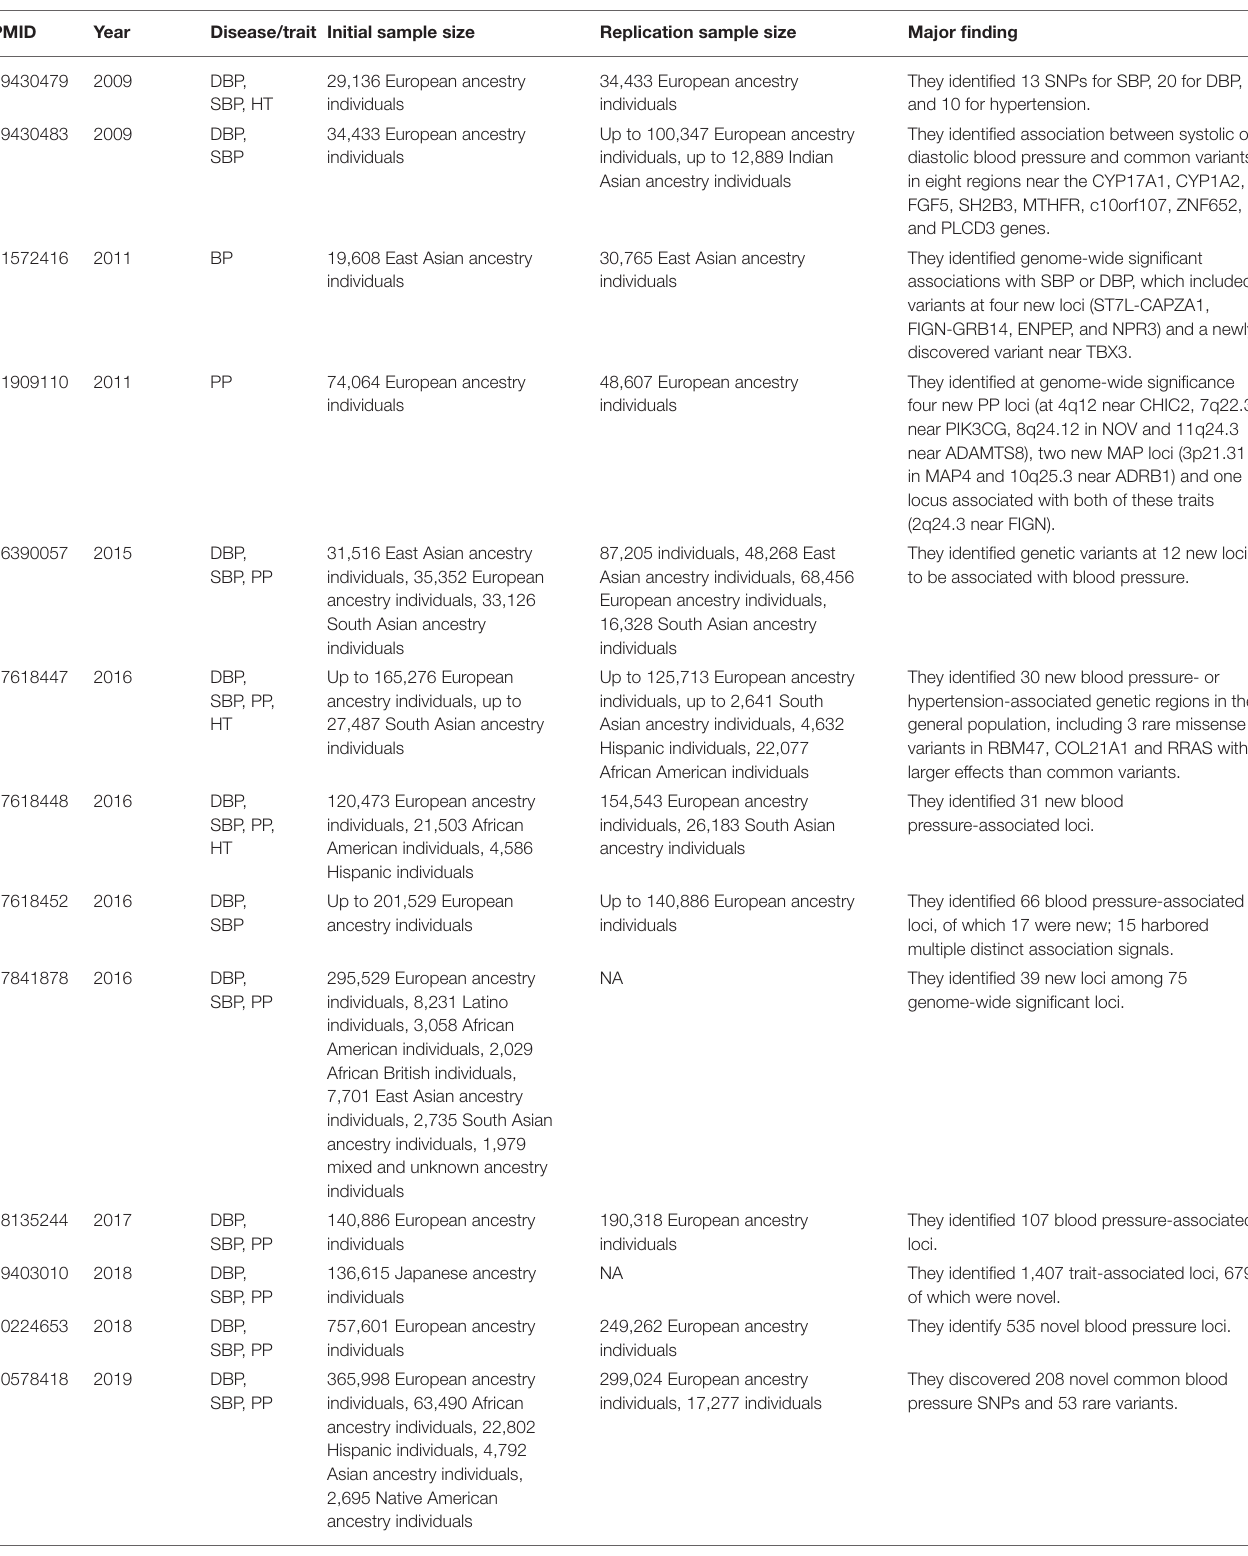
TABLE 1 | GWASs for hypertension or blood pressure published in NATURE GENETICS since 2007.